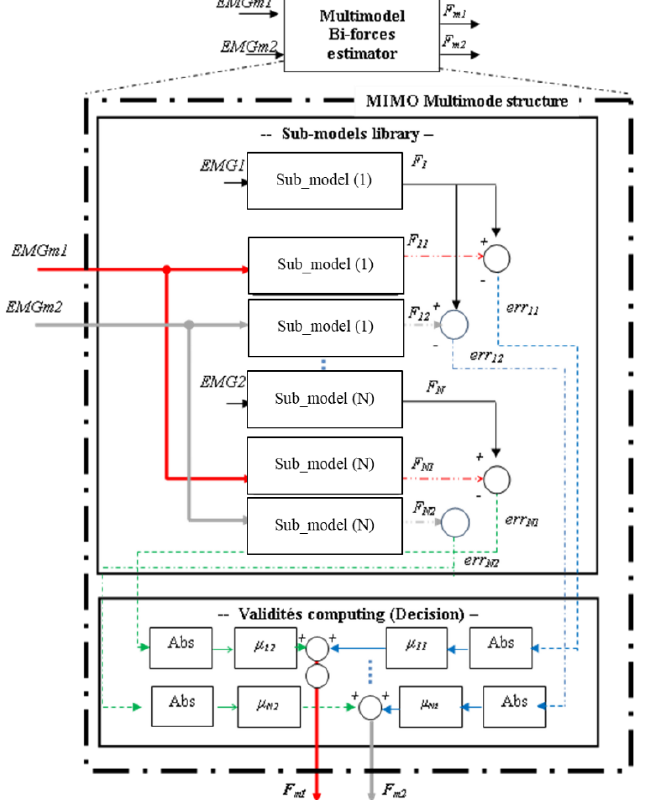
Figure 2. Multimodel structure to estimate two muscle forces F m1 and F m2 from two EMG signals EMGm1 and EMGm2 . For Figure 2, we define: